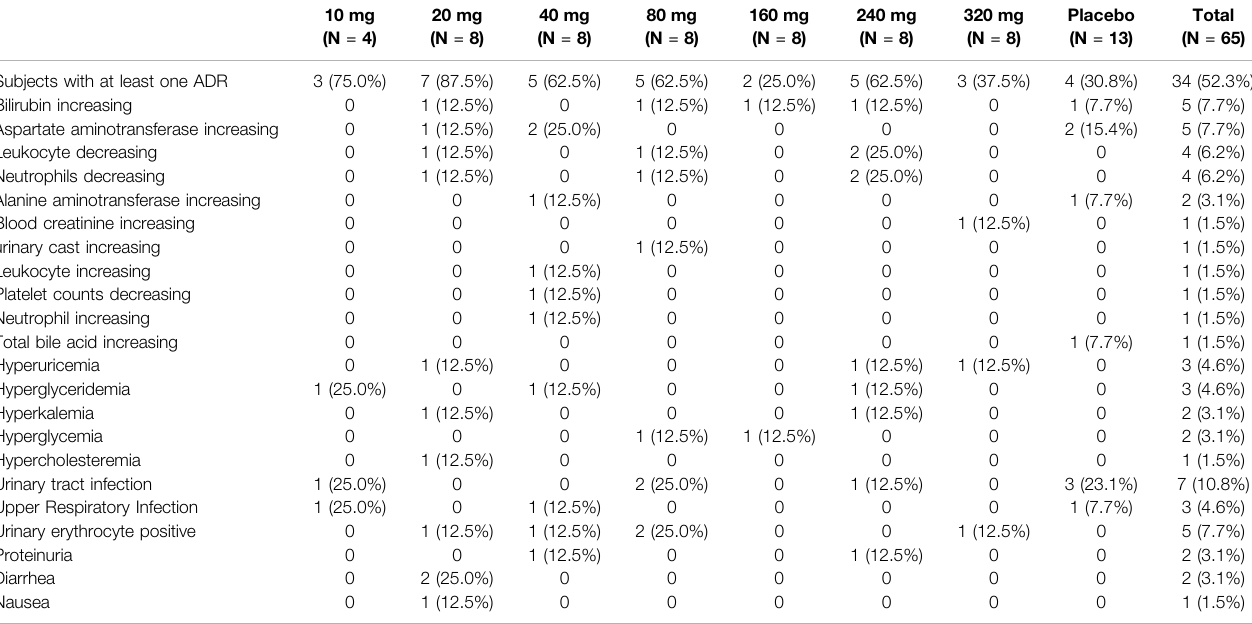
Data are shown as geometric mean (SD), except T max which are as median (Min – Max).